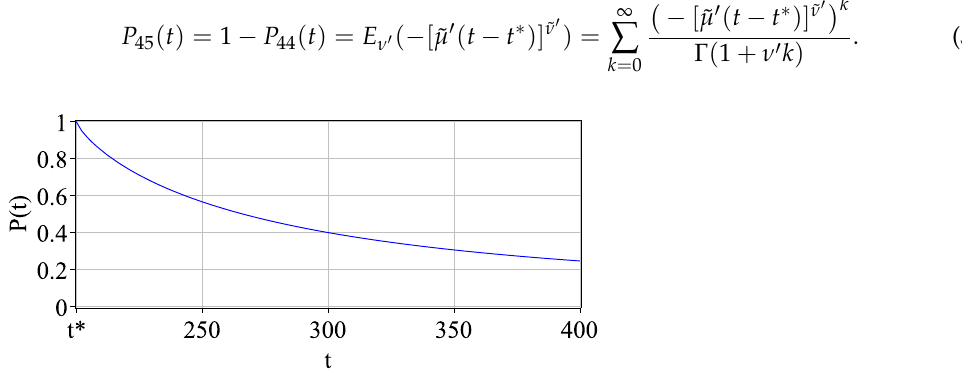
Figure 3. The plot of probability distribution P 45 ( t )